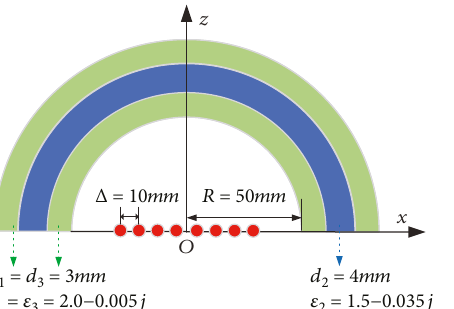
Figure 6: Geometrical model of a dipole array in a three-layer hemispherical dielectric radome.